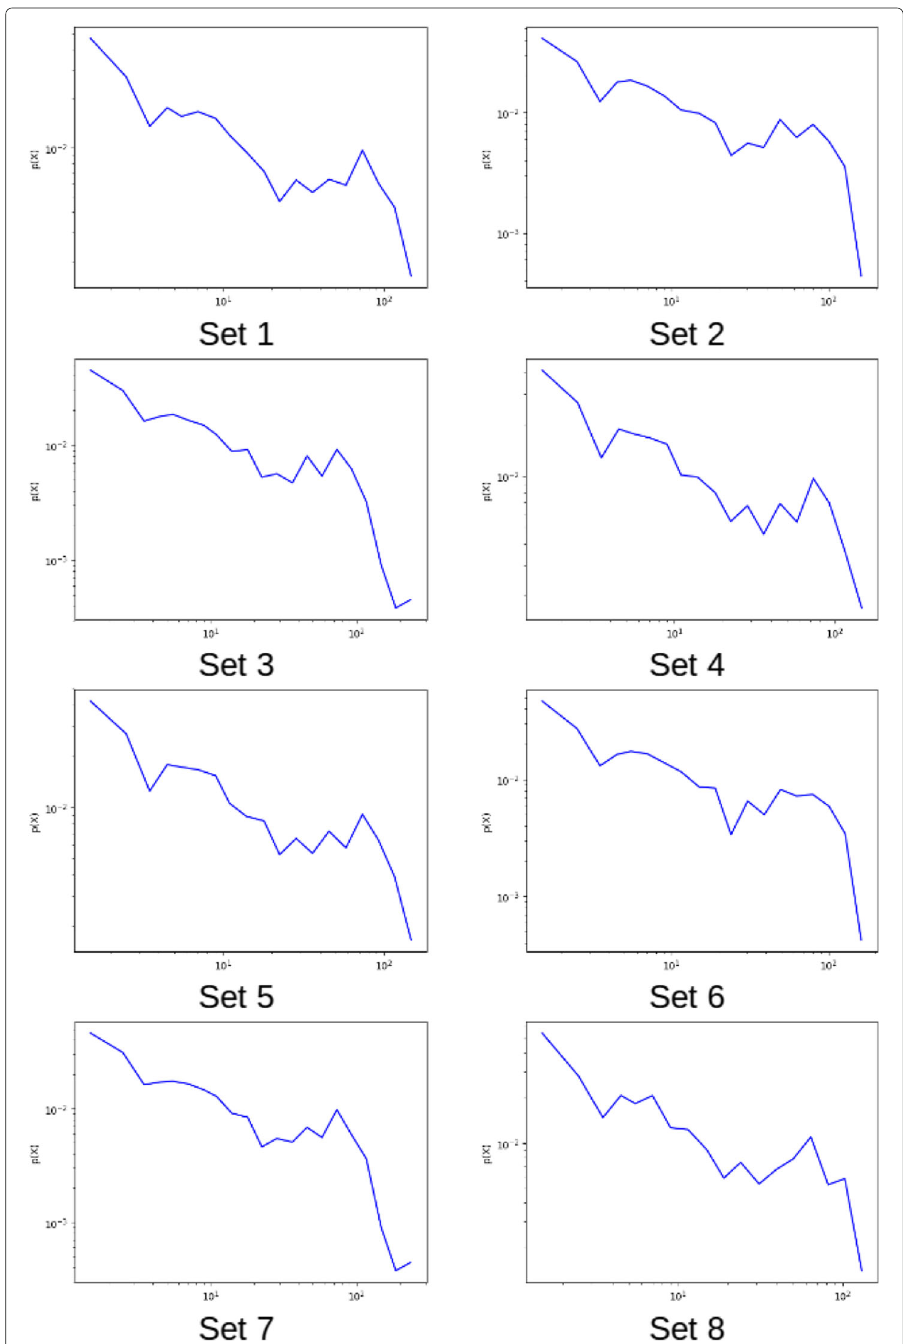
Fig. 6 Degree distributions of the Name extraction network for the eight datasets described in Table 4, in support of the findings in ResearchQuestion2 . The X-axis and Y-axis respectively plot the degree and its empirical frequency in the network. Scales are